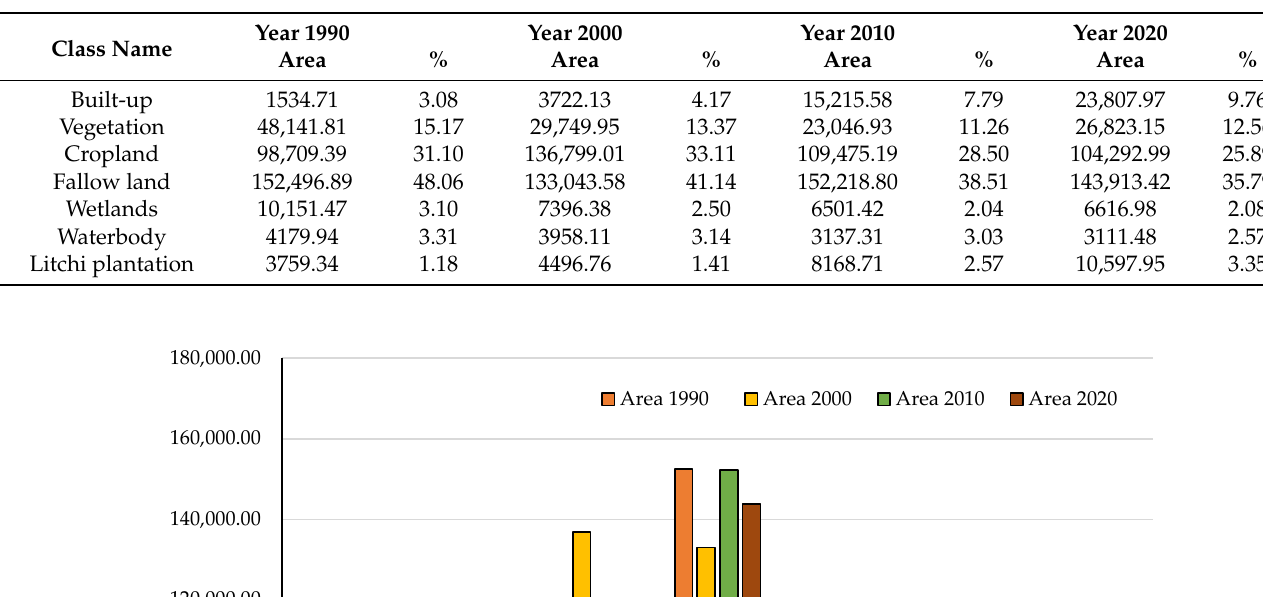
Table 3. Area estimates of LULC during the period of 1990 to 2020.